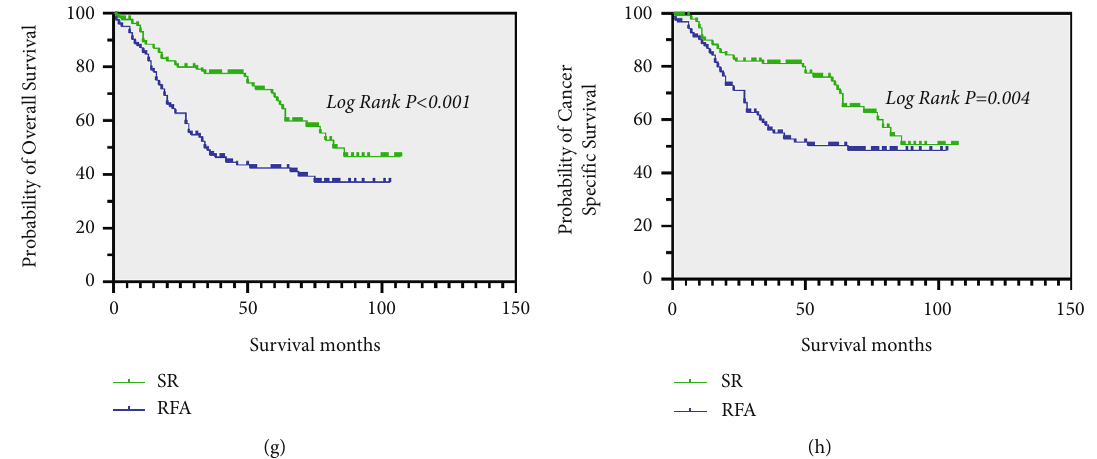
Figure 5: Kaplan – Meier curve of OS and CSS in patients with SR and RFA after PSM — (a and b) patients with an age at diagnosis between 30 and 59 years; (c and d) patients with an age at diagnosis between 60 and 84 years; (e and f) male patients; (g and h) female